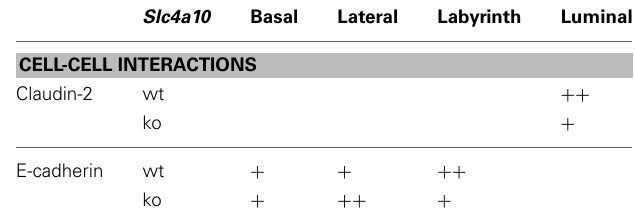
The subcellular sites basal, lateral, labyrinth, and luminal cover both the respec- tive parts of the plasma membrane proteins (transporters and cell-cell interaction proteins) and the sub-membrane part of the cytoplasm for soluble cytosolic proteins (anchoring and cytoskeletal